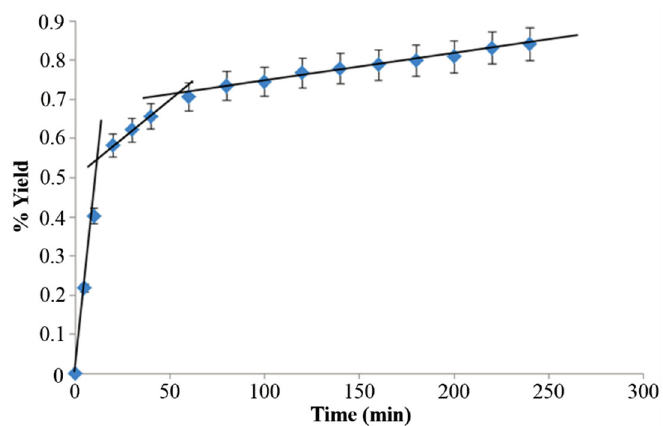
Figure 1. Extraction curve for scCO 2 extraction of maize